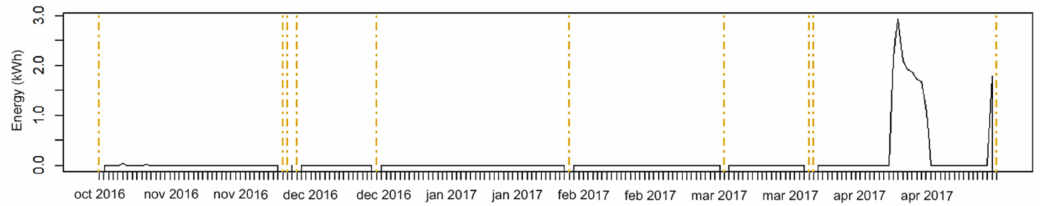
Figure 8. Example of installations labelled “Low consumption” and “Low usage”.